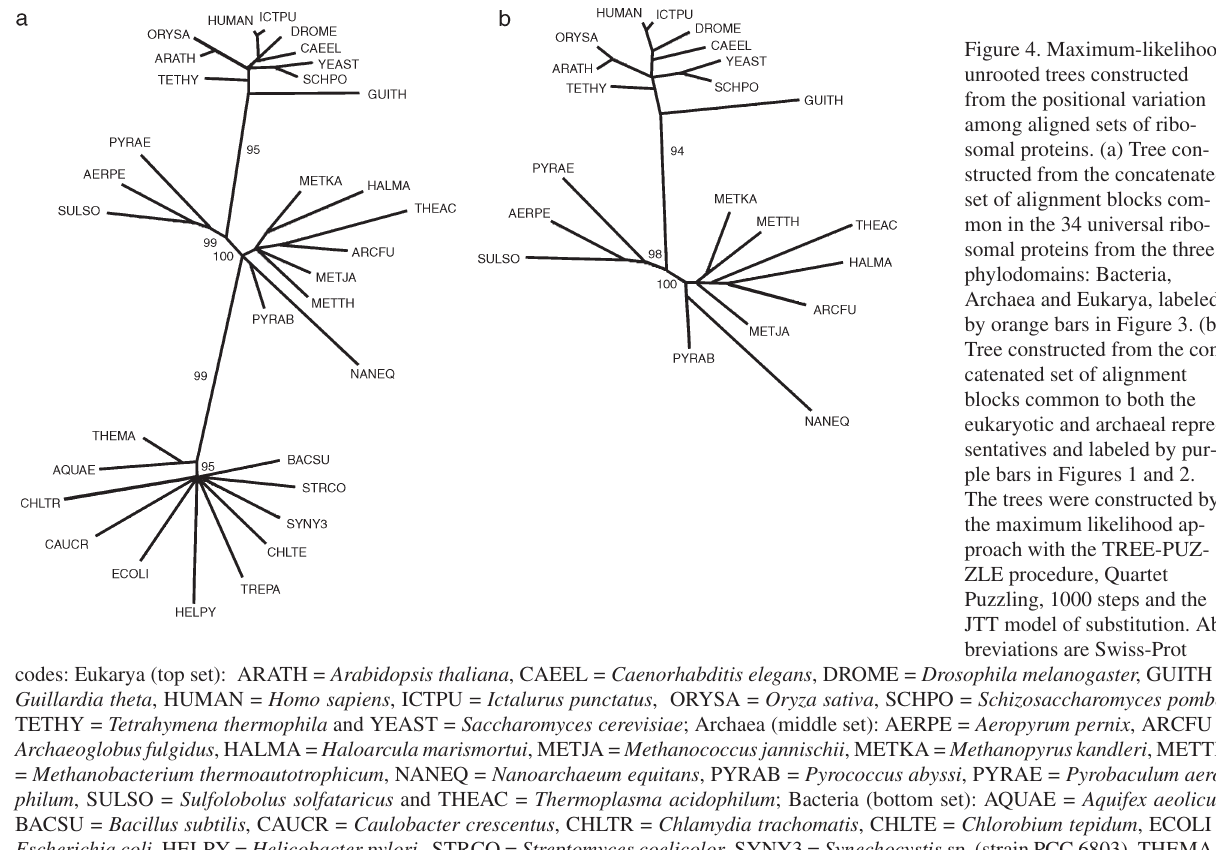
Figure 4. Maximum-likelihood unrooted trees constructed from the positional variation among aligned sets of ribo- somal proteins. (a) Tree con- structed from the concatenated set of alignment blocks com- mon in the 34 universal ribo- somal proteins from the three phylodomains: Bacteria, Archaea and Eukarya, labeled by orange bars in Figure 3. (b) Tree constructed from the con- catenated set of alignment blocks common to both the eukaryotic and archaeal repre- sentatives and labeled by pur- ple bars in Figures 1 and 2.